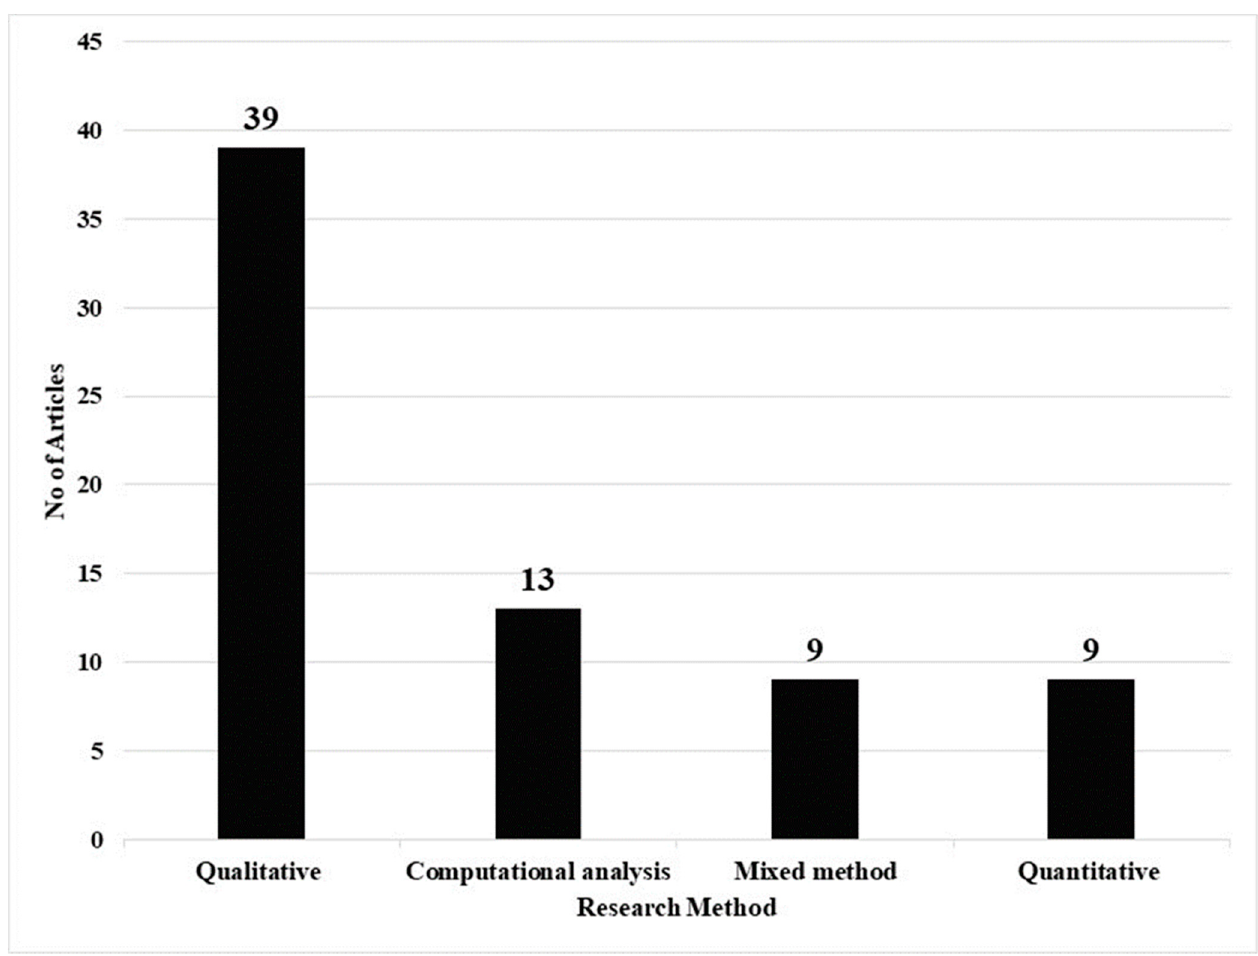
Figure 4. Research methods applied in the articles.